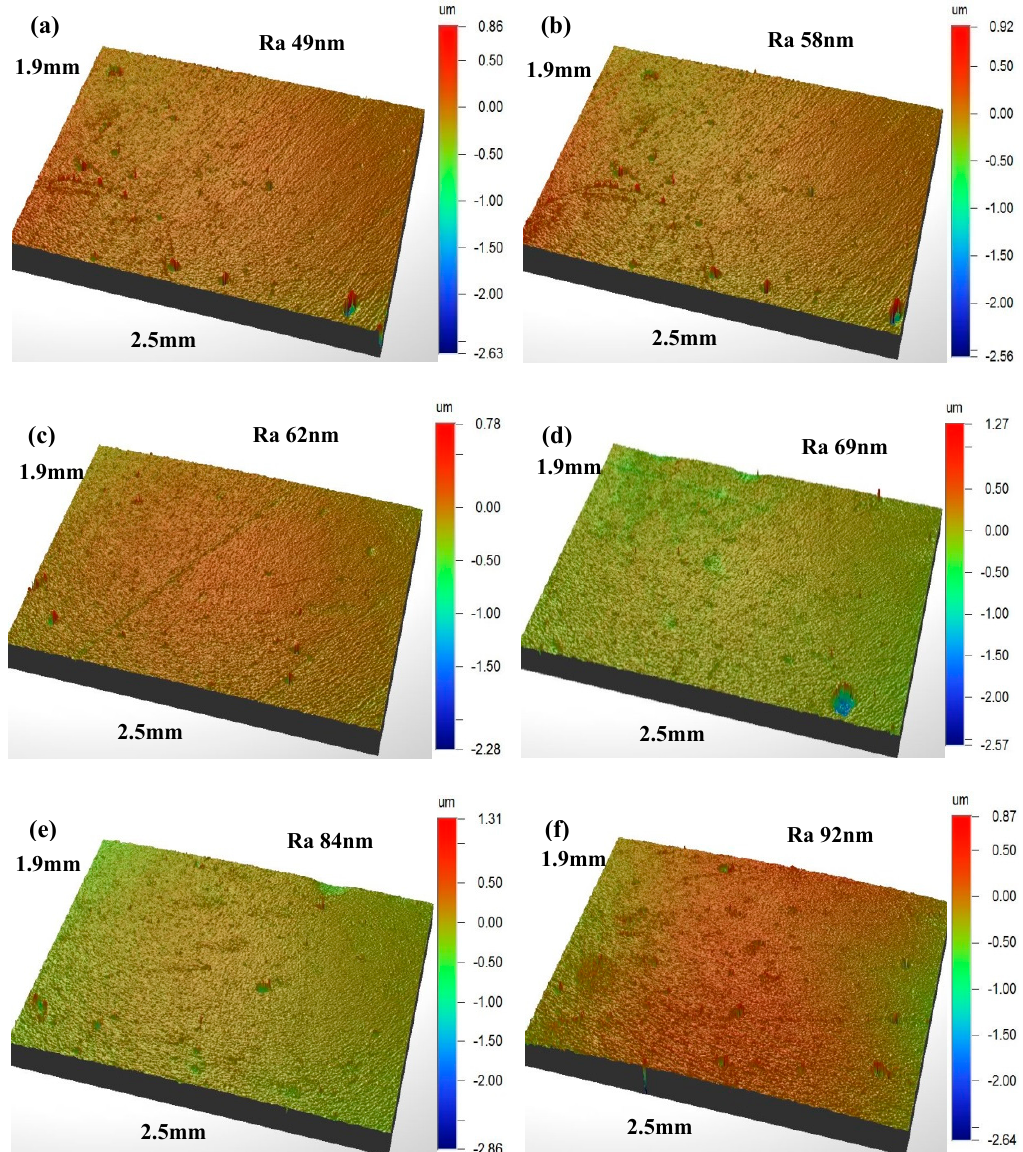
Figure 3. Surface topography of the composite coatings detected by a white light interferometer at di ff erent Zr current ( a ) 0 A; ( b ) 30 A; ( c ) 45 A; ( d ) 60 A; ( e ) 80 A; ( f ) 100 A.